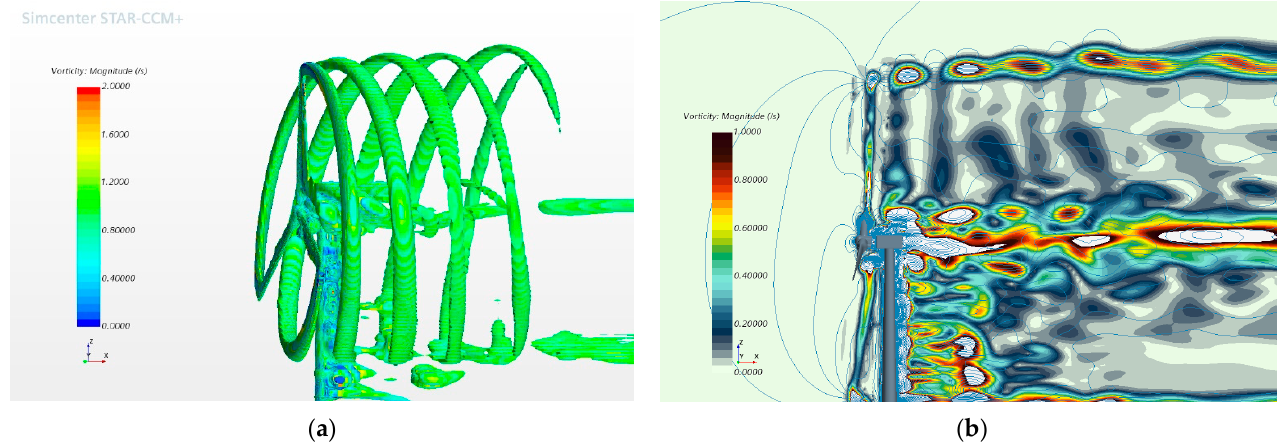
Figure 12. Wake scheme under surge motion. ( a ) Iso-surface at T0 moment under case 10; ( b ) velocity in the symmetry plane at T0 moment under case 10.